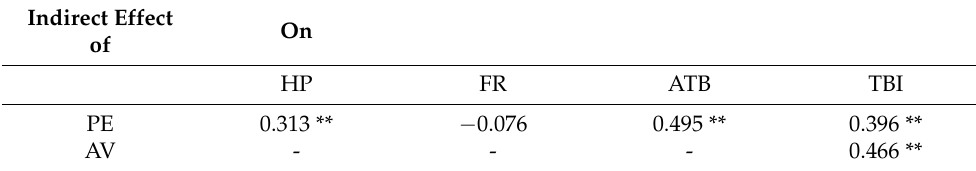
Table 4. Summary of indirect effect assessment results.